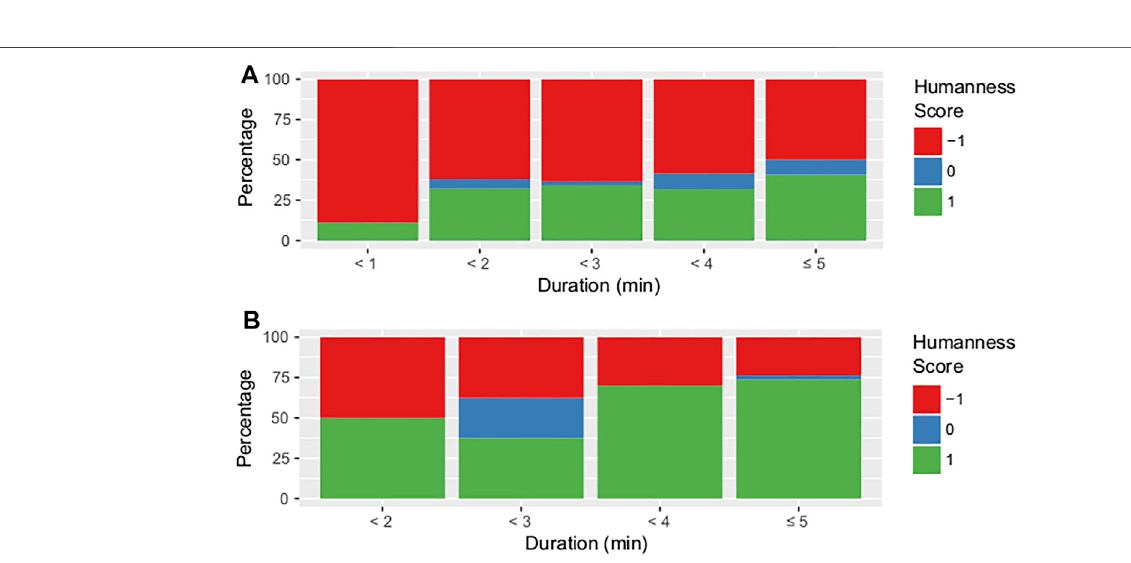
Frontiers in Computer Science |